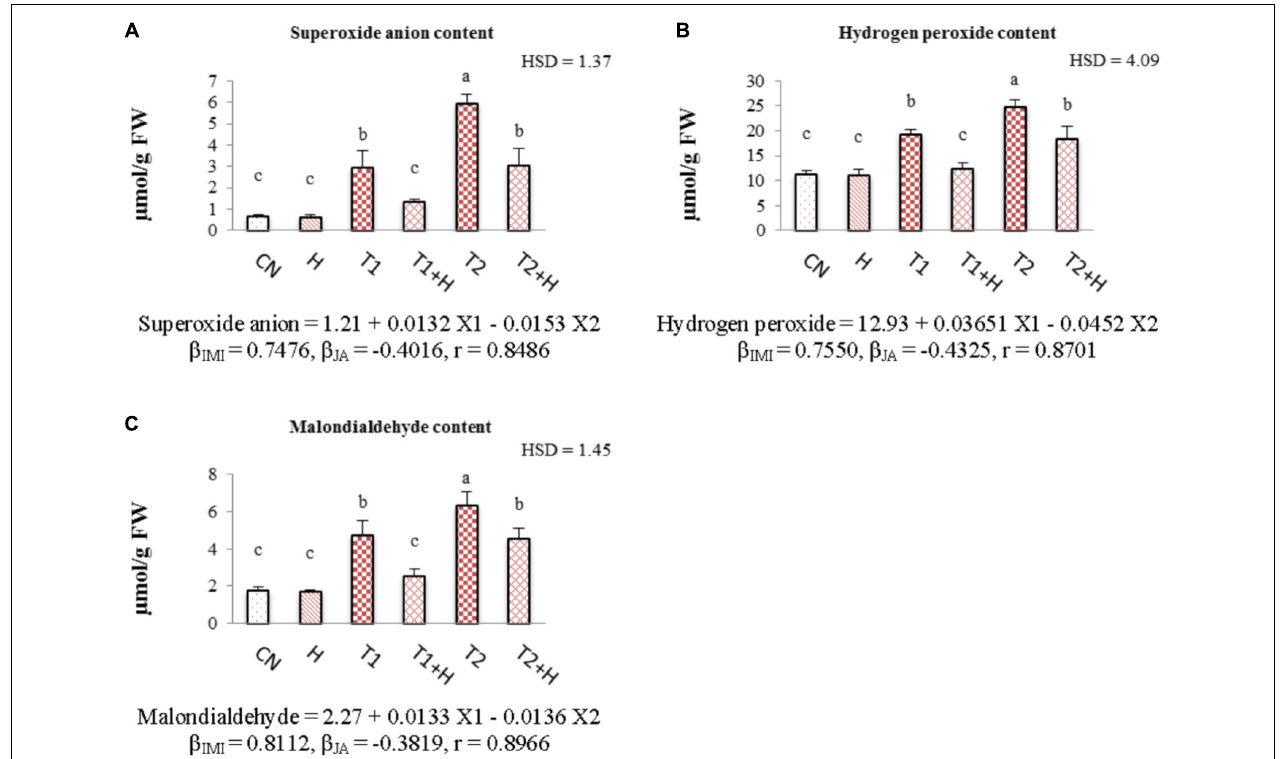
FIGURE 4 | Effect of JA seed soaking on the contents of oxidative stress markers in B. juncea seedlings under IMI stress. Data shown here are mean ± SD ( n = 3). Means with same letters are not significantly different from each other, IMI, imidacloprid (X1); JA, jasmonic acid (X2); T1, 200 mg · L − 1 (IMI); T2, 250 mg · L − 1 (IMI); H, 100 nM (JA), r, multiple correlation coefficient. β = β -regression coefficient. A = superoxide anion; B = hydrogen peroxide; C =